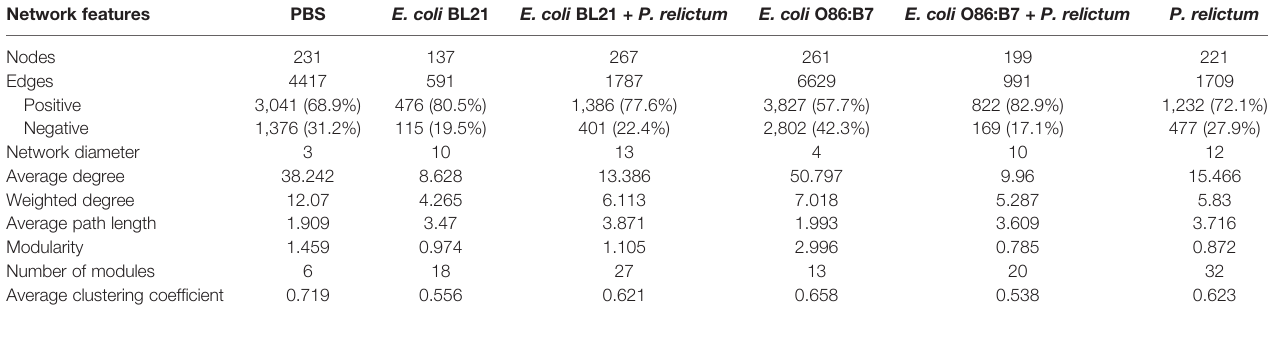
TABLE 1 | Topological parameters of co-occurrence networks.